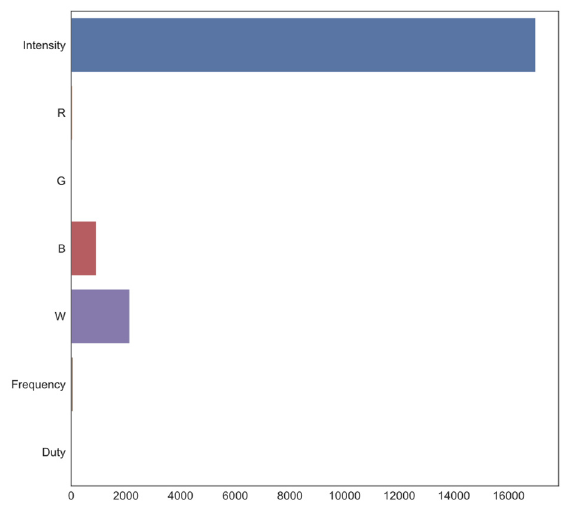
Figure 6. Mutual information evaluated versus the features in the dataset. Table 5. Mutual information gain values for the energy consumption dataset.